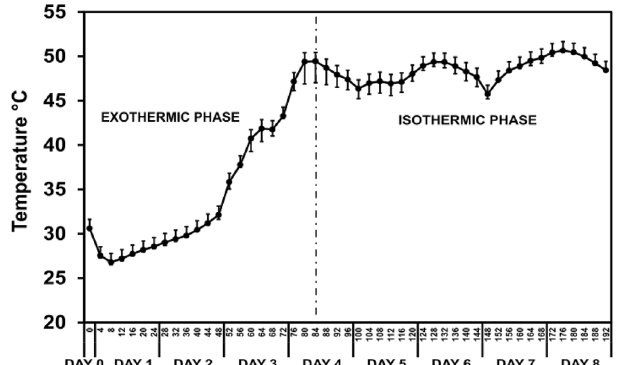
Figure 5. Temperature dynamic during the fermentation of fine-flavor cocoa. The dotted line divides cocoa fermentation temperature dynamics into two